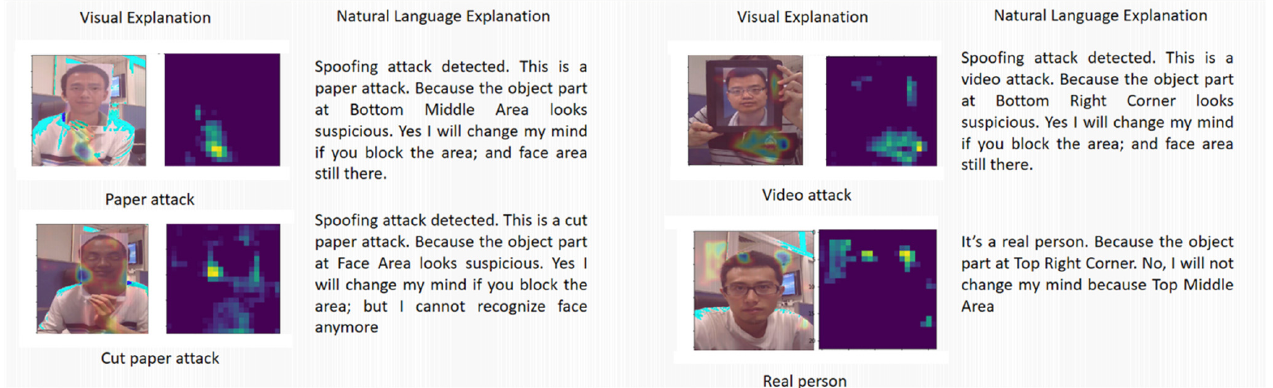
Figure 4. Explanation examples generated by the model for different presentation attack species. In each case, the system provides a saliency map and heatmap as visual justification for the decision and a short paragraph as the natural language explanation (see Table 1 for the list of possible verbal explanations).